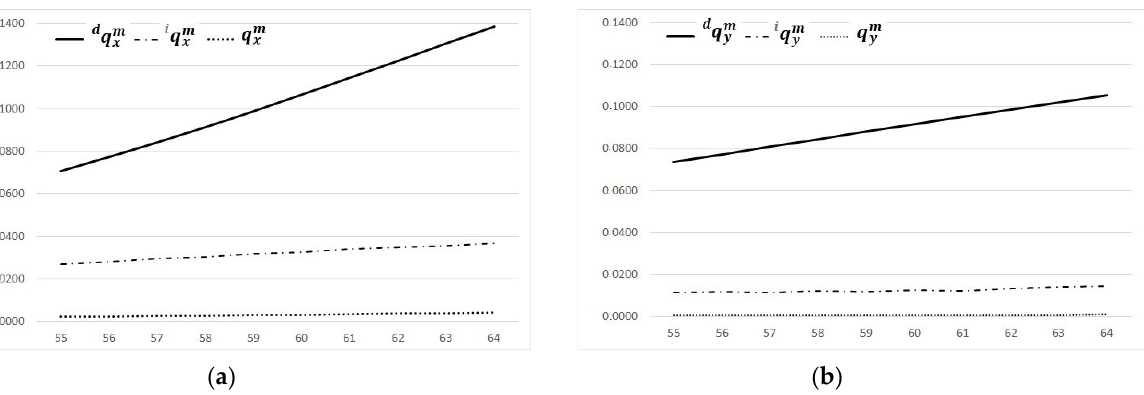
Figure 2. Mortality differential by status and gender in the last 10 years of work activity. ( a ) Men; ( b ) women. Source: Own work. Database: PERM/F 2000 mortality tables for the general population [64]; Spanish social security actuarial tables for disability [65]; severe and high dependency mortality tables in Spain [71].